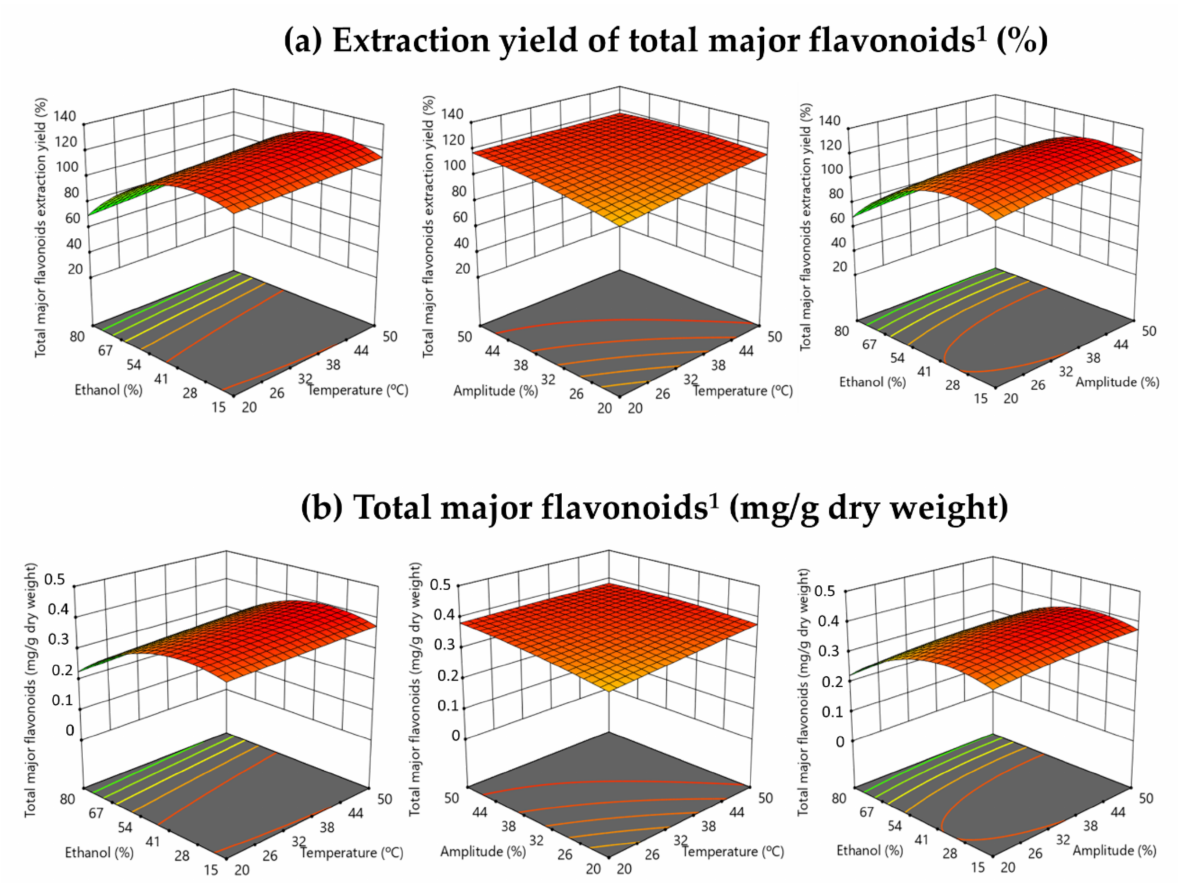
Figure 4. Response surface graph illustrating the effect of the three independent variables (amplitude (%), temperature ( ◦ C) and ethanol in solvent (%, v / v )) on total most abundant flavonoids ( a ) extraction yield (%) and content (mg/g dry weight). 1 Sum of major identify flavonoids: Isorhamnentin glucoxyl-rhamnosyl-pentoside (IG2), Quercetin-3-O-rhamnosyl-rutinoside (QG3) and Quercetin glycoside (QG2)—Quercetin hexose